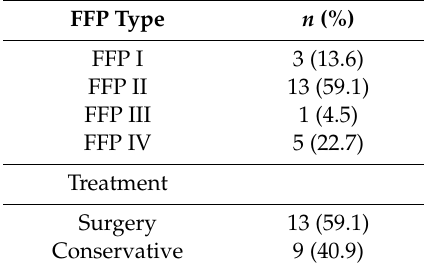
Table 2. FFP Classification and Treatment.